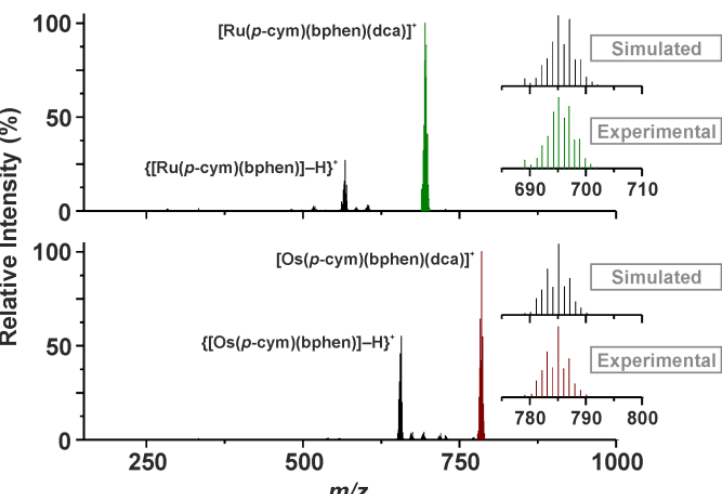
Figure 2. Electrospray ionization (ESI+) mass spectra of complexes Ru-dca (top) and Os-dca (bottom) given together with the details of the experimental and simulated peaks of the [M( p cym)(bphen)(dca)] + species (M = Ru or Os).